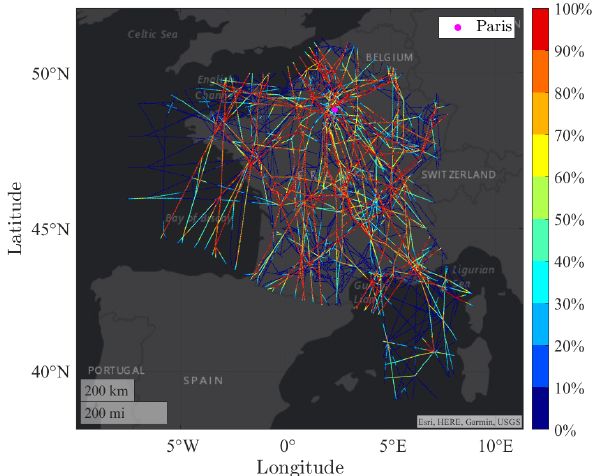
Figure 9. Full day of air traffic over French airspace, colorized according to their initial complexity. The trajectories with the lowest complexity are shown in blue, whereas the highest are drawn in red.